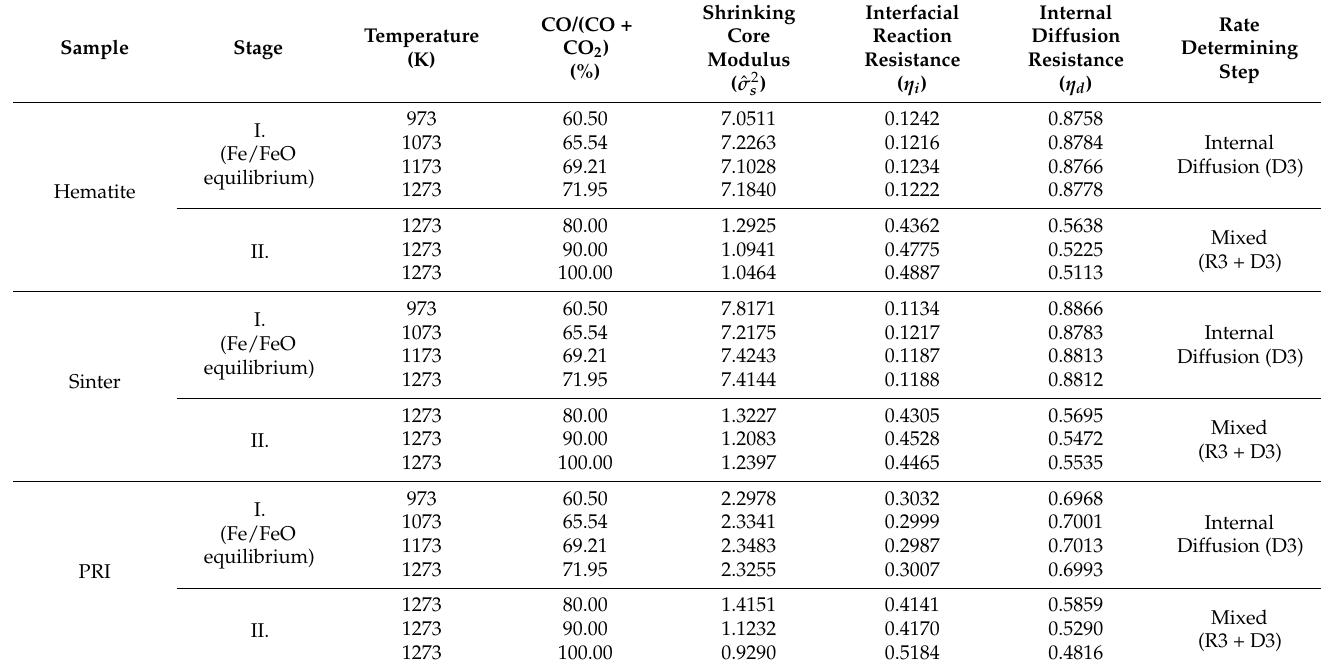
Table 3. Relative resistance between interfacial reaction and internal diffusion under experimental conditions in the present